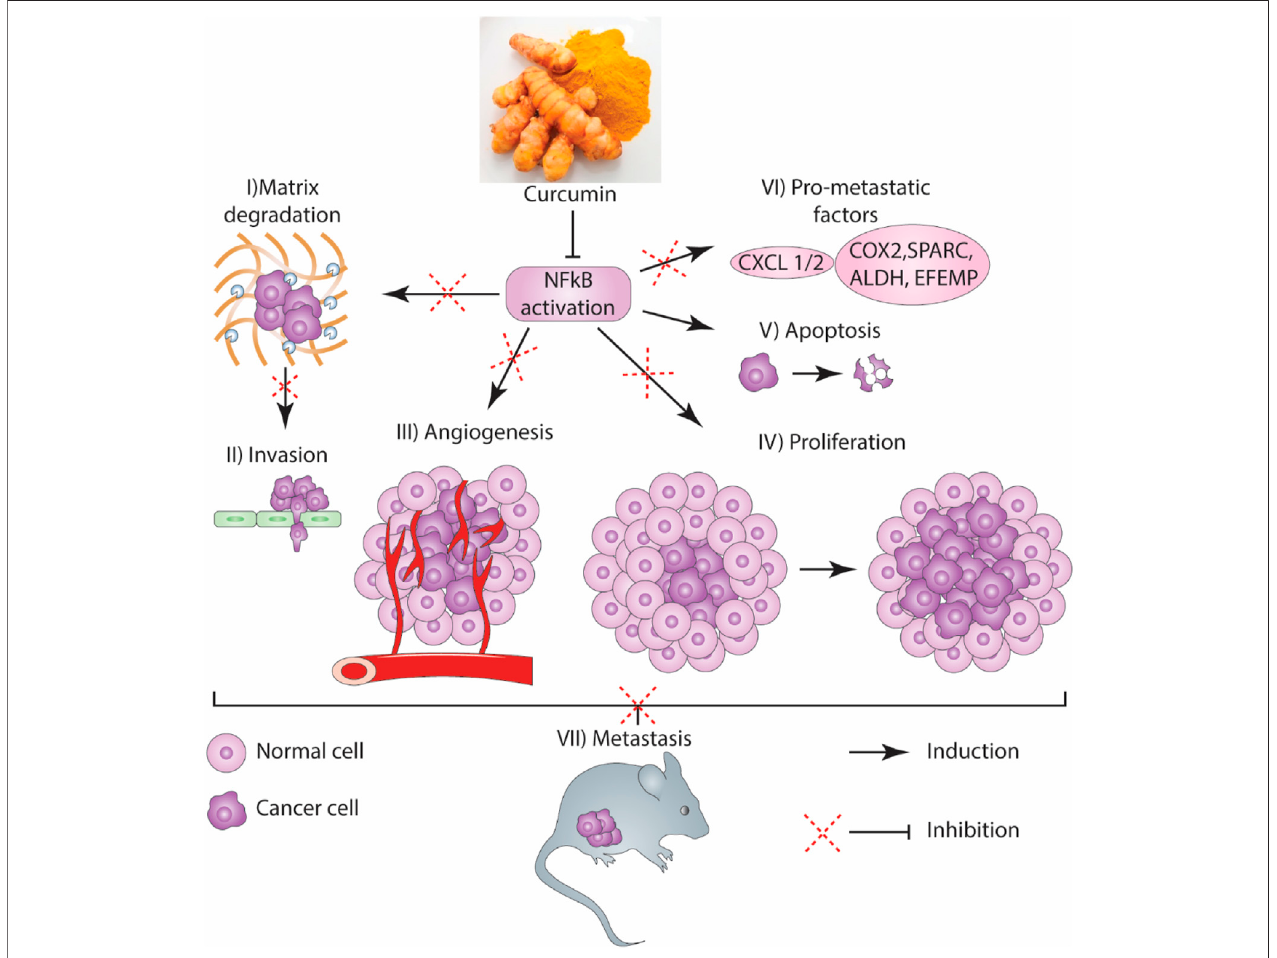
FIGURE 6 | A schema of the antimetastatic effects of curcumin in GI cancers.